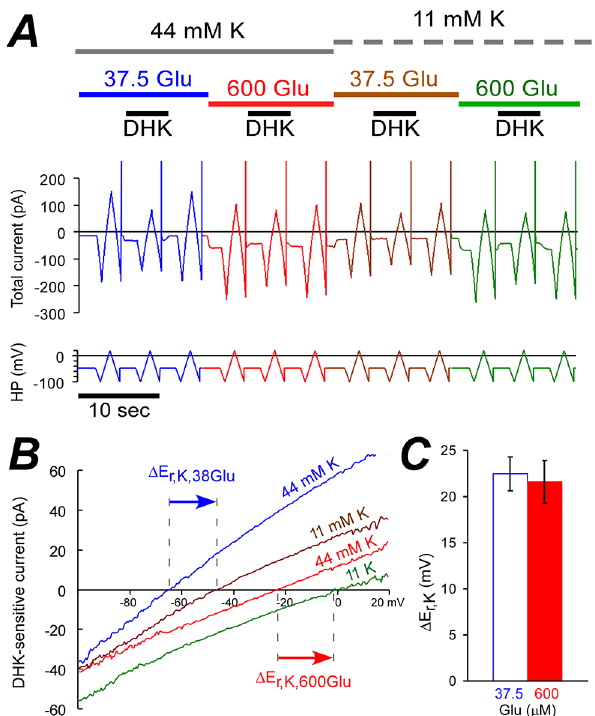
Fig 3. Four-fold decrease in [K + ] e shifted GLT-1a E rev by +22 mV at both low and high glutamate concentrations. (A) Representative experiment shows the current with the identifying clues as in Fig 1B. (B) I-V curves of DHK sensitive currents obtained form (A) . Arrows show GLT-1a E rev shifts. (C) Average GLT-1 E rev shifts at 37.5 μ M and 600 μ M are approximately equal when [K + ] e was decreased from 44 to 11 mM.